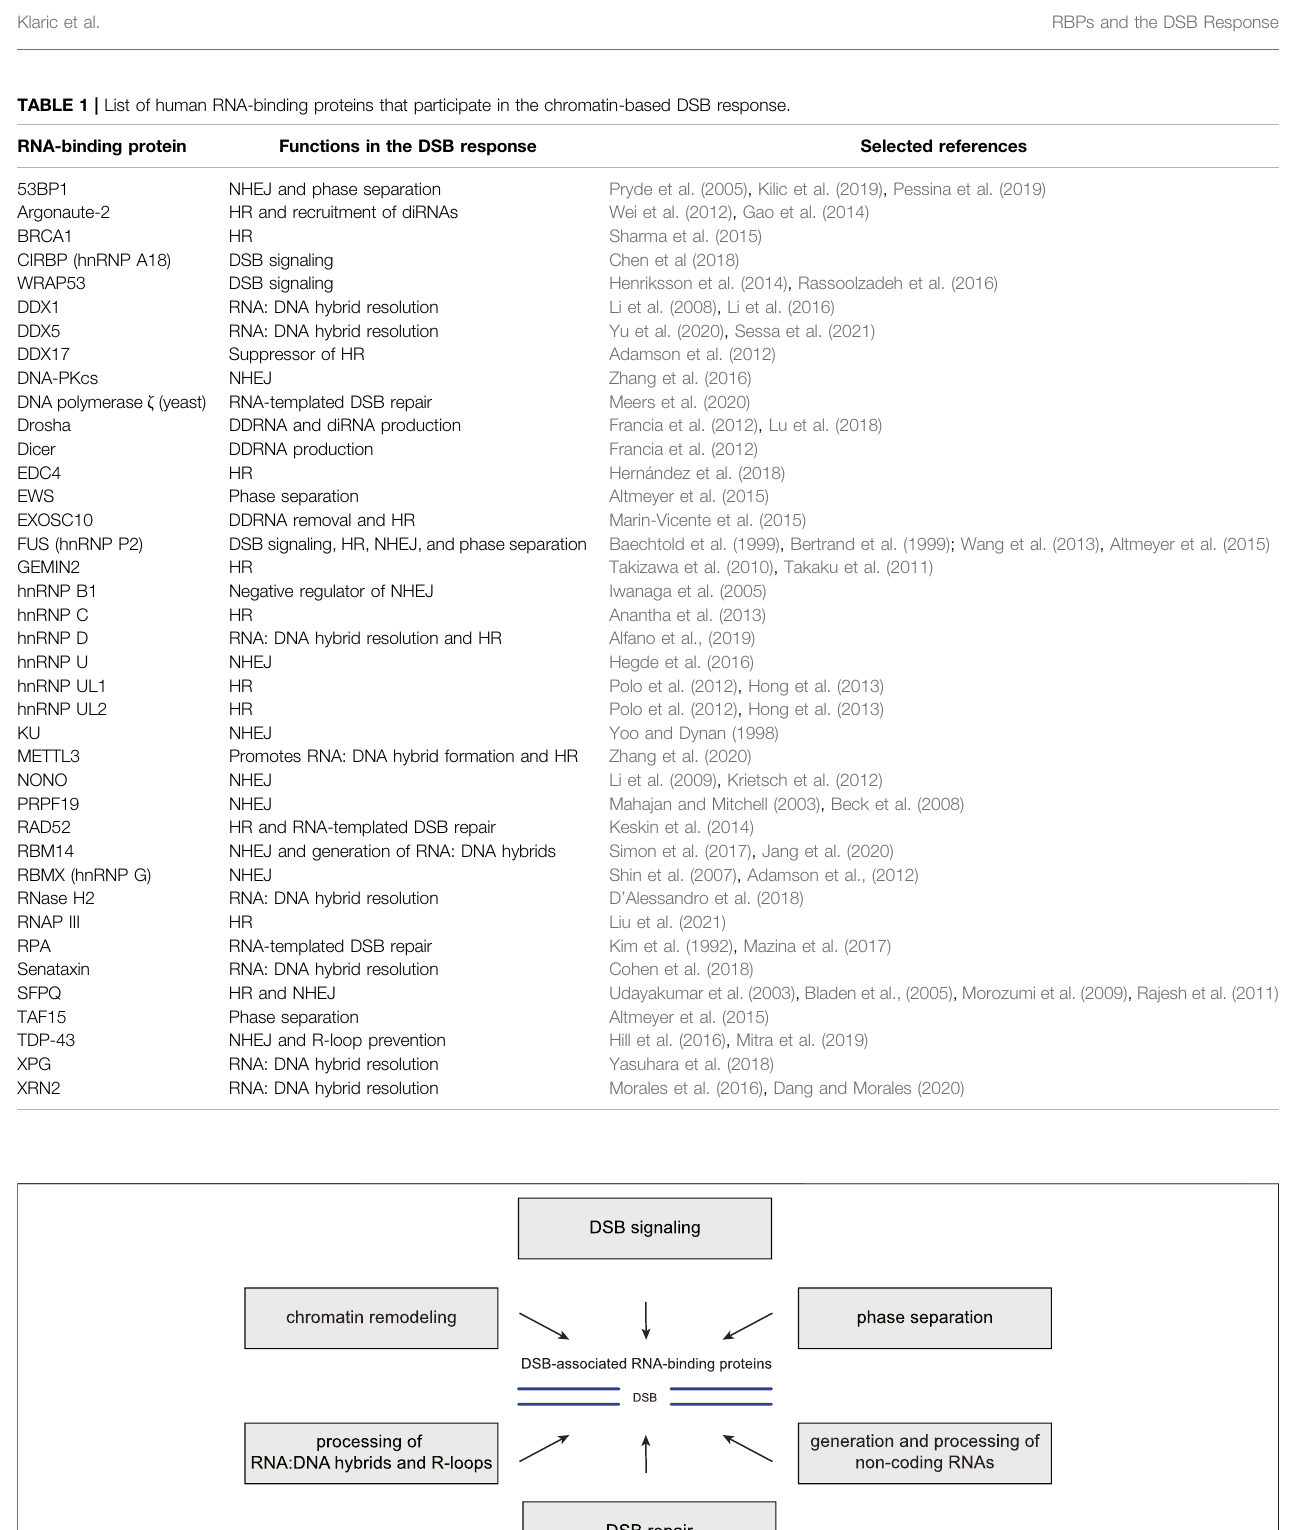
Frontiers in Molecular Biosciences |